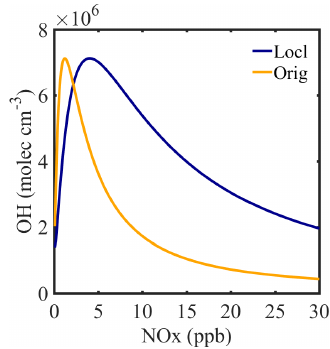
Figure 1. The localized (blue line) and original (yellow line) param- eterization of the NO x –OH concentration curve in the P6 scheme. The input parameters used to calculate the curve were annually av-